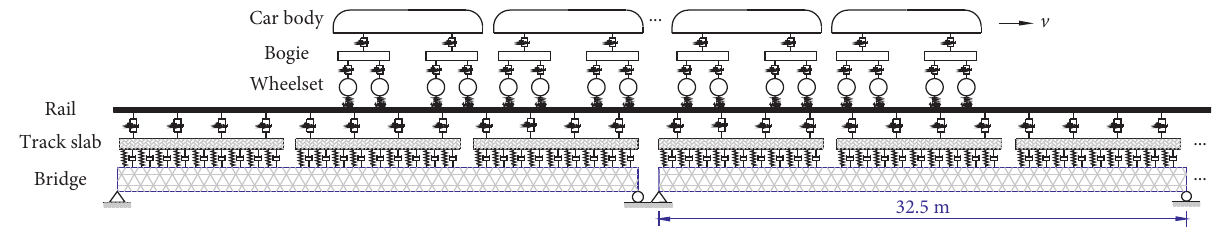
Figure 1: Train-slab track-bridge coupled dynamics